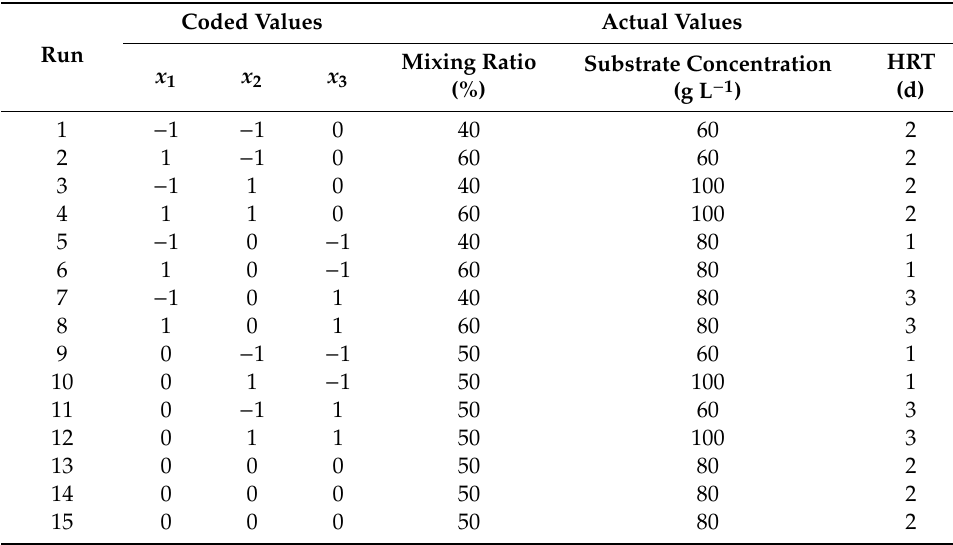
Table 2. Experimental design matrix. HRT: hydraulic retention